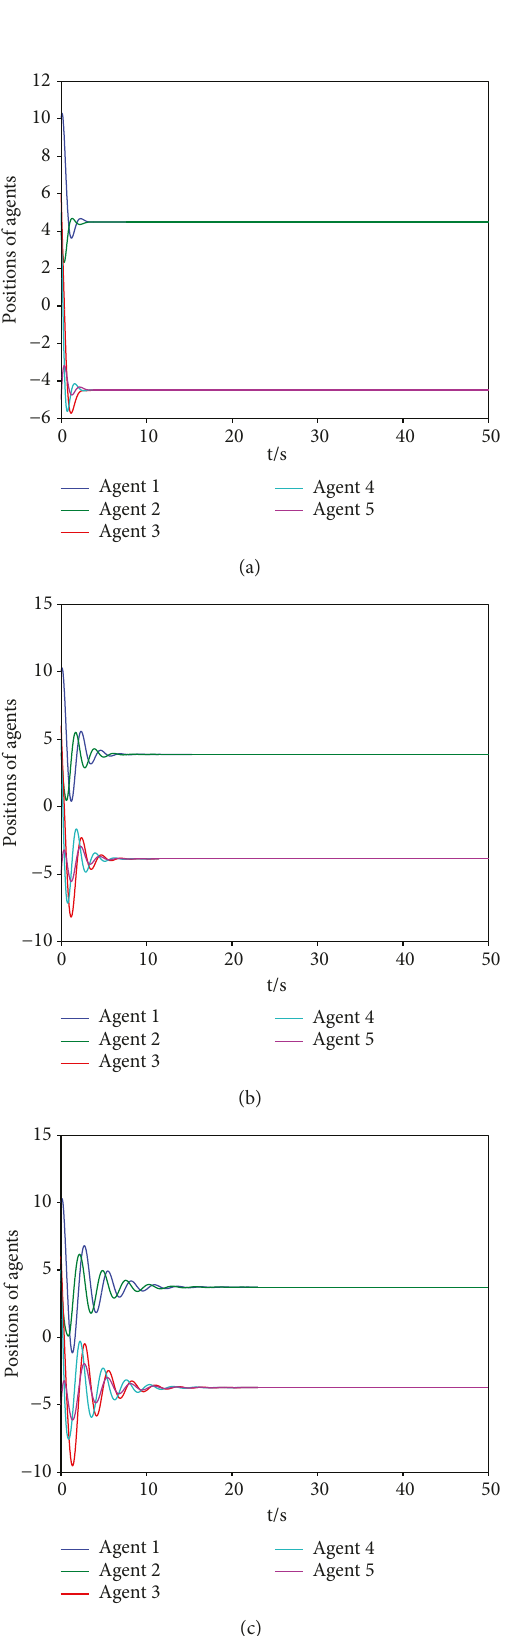
Figure 4: The agents ’ position trajectories, where τ τ = 0 5 , τ = 0 25 , and τ 3 4 τ = 0 8 ij